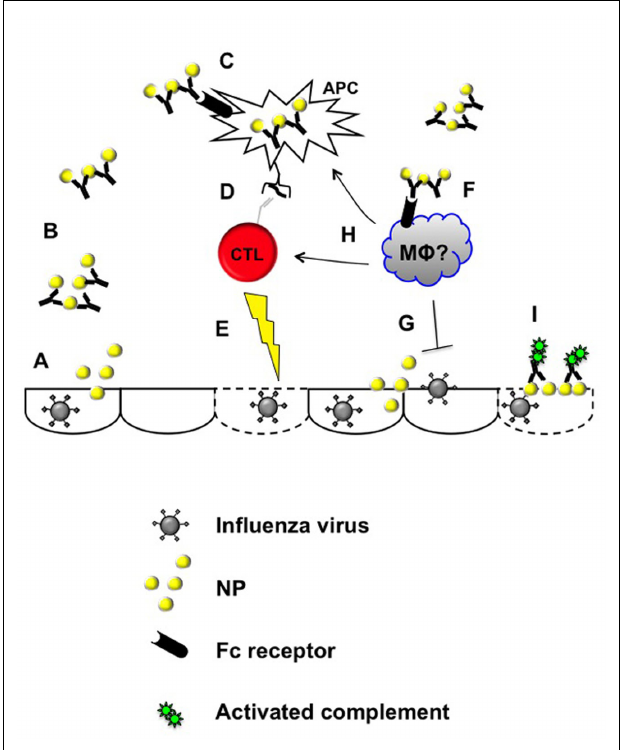
FIGURE 4 | Proposed mechanisms for antibody against influenza nucleoprotein. Virus-infected cells (typically epithelia) release NP protein (A) , which would then be available to NP-specific antibody. Immune complexes formed by antigen and antibody (B) could thus engage Fc receptors on leukocytes (C,F) triggering antiviral reactions.These reactions may include enhanced antigen presentation by dendritic cells or other antigen-presenting cells (C,D) , which could then in turn enhance antiviralT cell responses capable of eliminating virally infected epithelia (E) . Alternatively or additionally, Fc receptor engagement on macrophages or other leukocytes (F) may execute antiviral reactions directly (G) or more indirectly by enhancing the antiviralT cell response at various levels (H) . Anti-NP antibody engagement of plasma membrane-associated NP could also trigger complement-mediated lysis of infected cells (I)